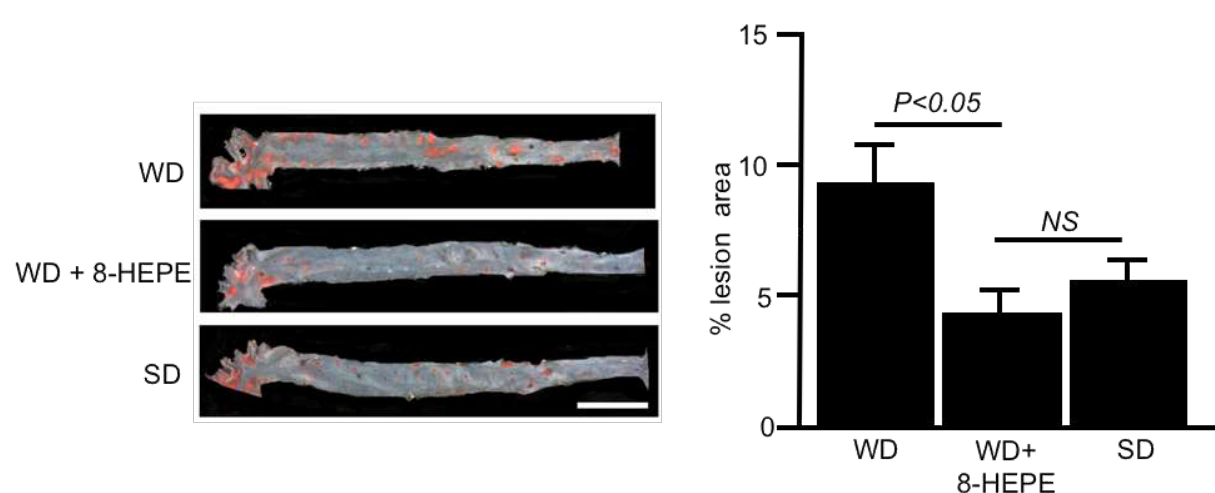
Figure 3. Representative images of the aorta ( left ) stained with Sudan IV and percentage lesion area of atherosclerosis ( right ) in apoE-KO mice fed a Western diet (WD) only or a WD with 8-HEPE (WD + 8-HEPE). Data are the mean ± SE obtained from eight mice for each group. An analysis of variance (ANOVA) with Dunnett’s test was used for the statistical analysis. SD, standard diet; NS, not significant.